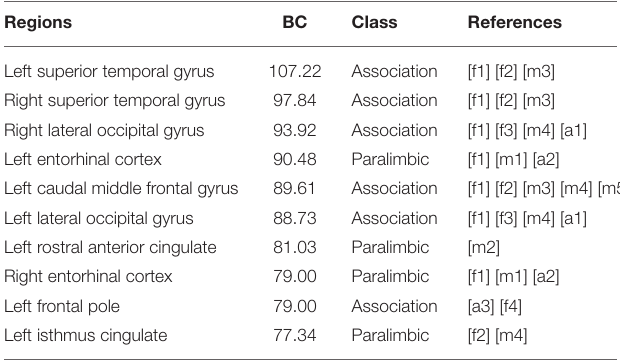
TABLE 2 | The hubs distribution based on the average BC of all the subjects and the entire sparsity range.